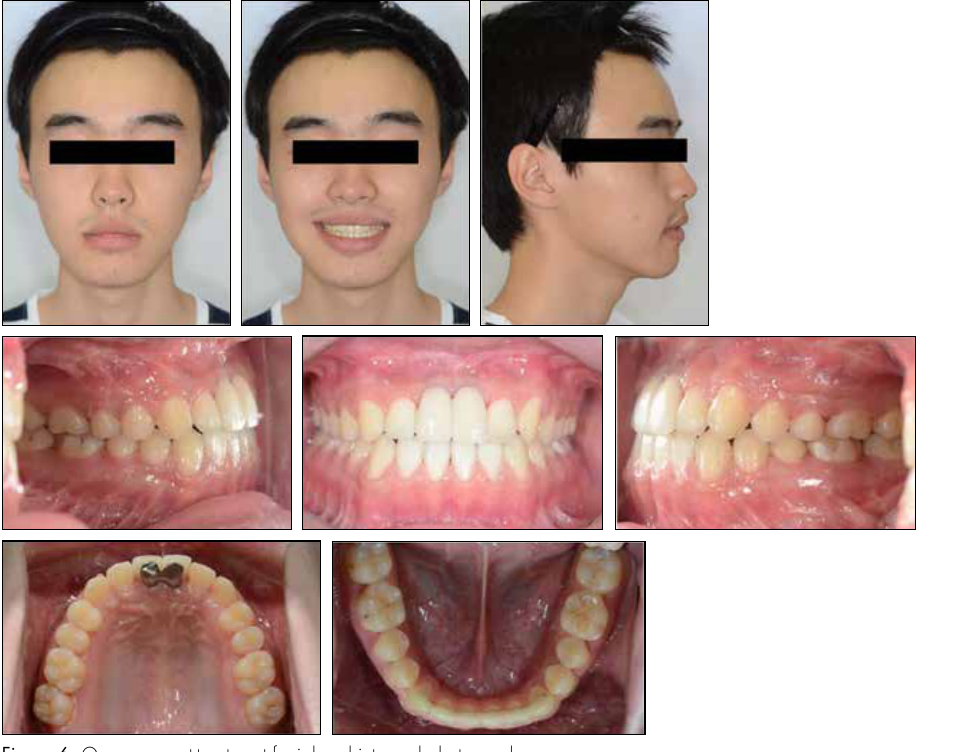
Figure 6. One-year post-treatment facial and intraoral photographs.